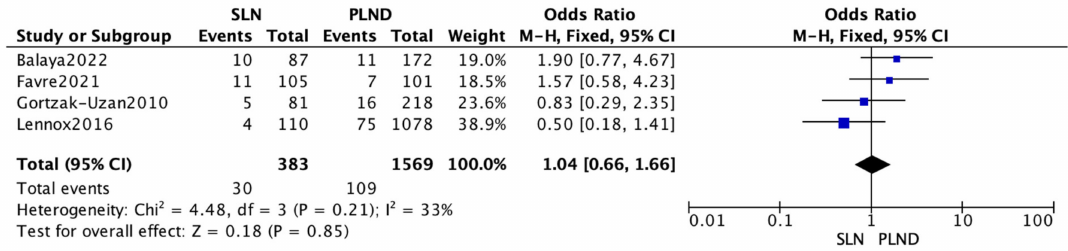
Figure 2. Disease-Free Survival.